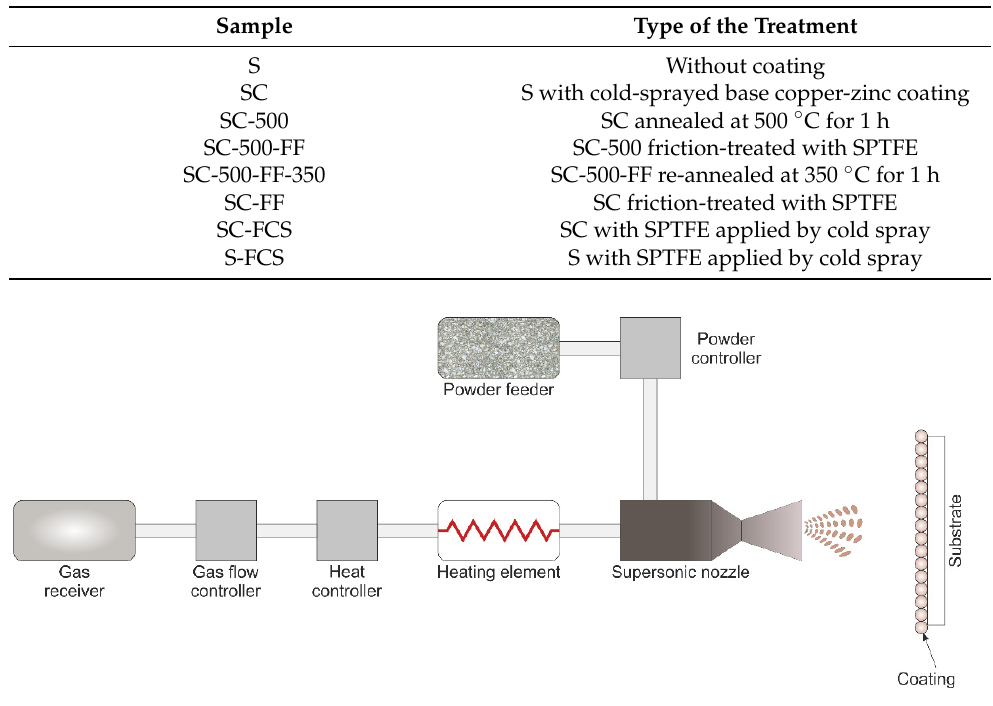
Figure 2. Scheme of the cold spray DIMET ® equipment.